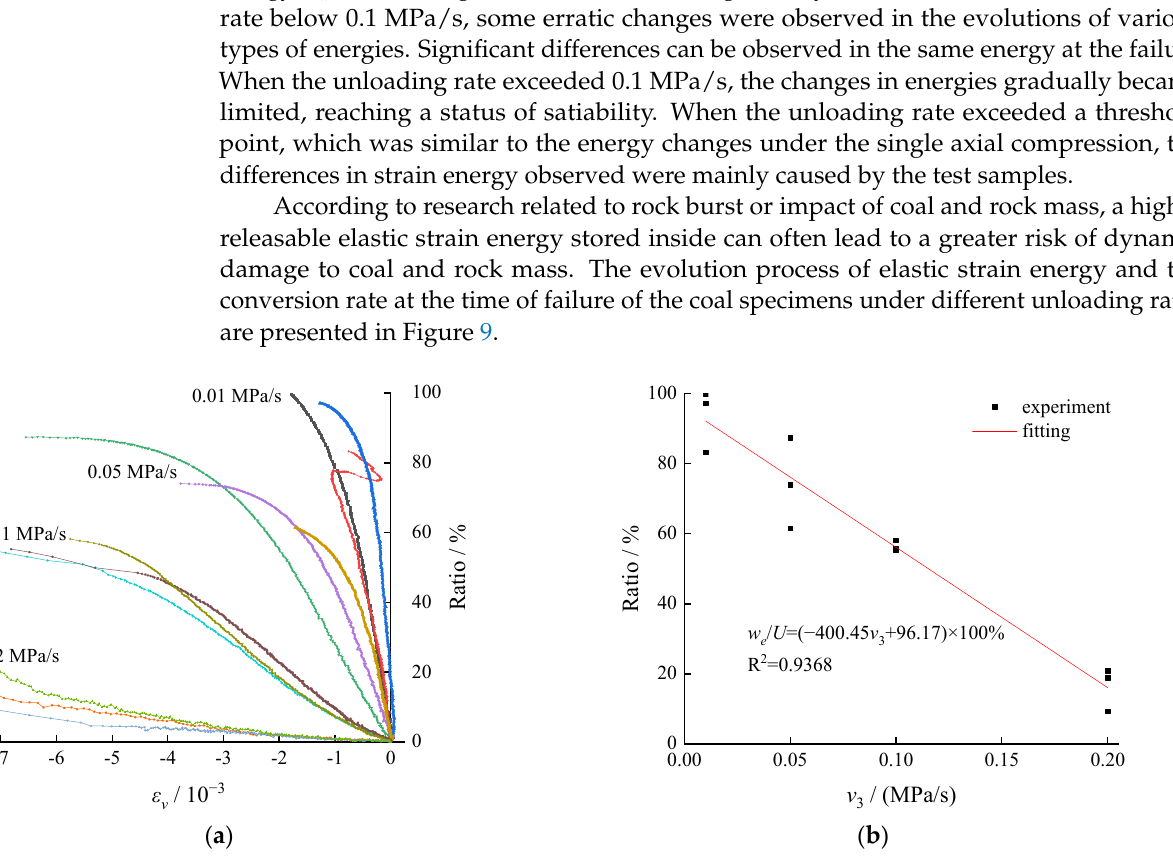
Figure 9. Elastic energy conversion rate: ( a ) conversion rate of elastic energy–volumetric strain evolution curve and ( b ) conversion rate of elastic strain and unloading rate.